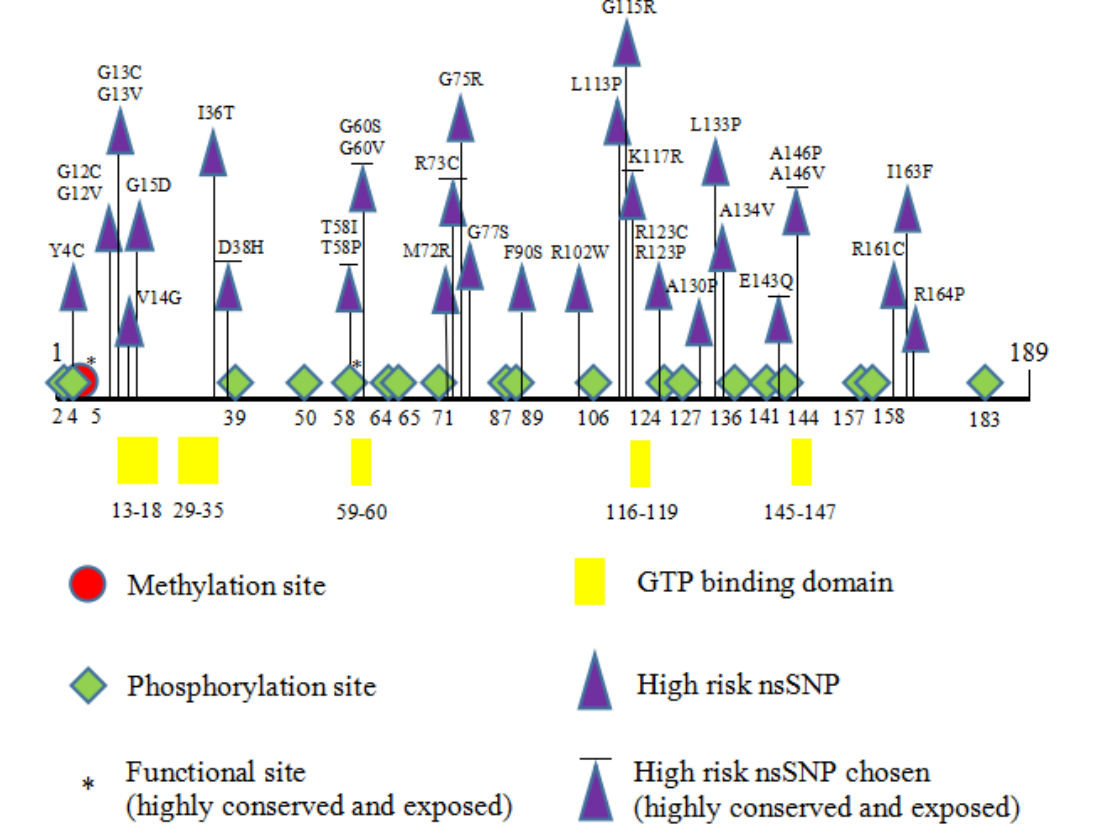
Figure 3. Putative PTM sites of high-risk nsSNPs in HRAS protein.